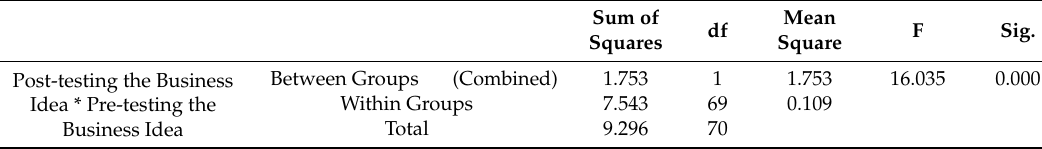
Table 4. Business idea ANOVA Table for the Hackathon